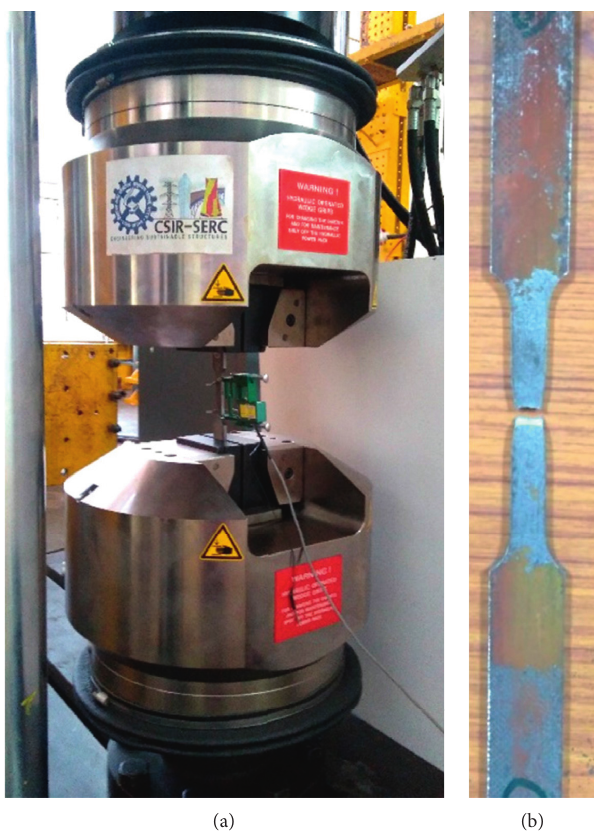
Figure 2: Test details of coupon tests carried out in this investigation. (a) Test set-up (b) Tested